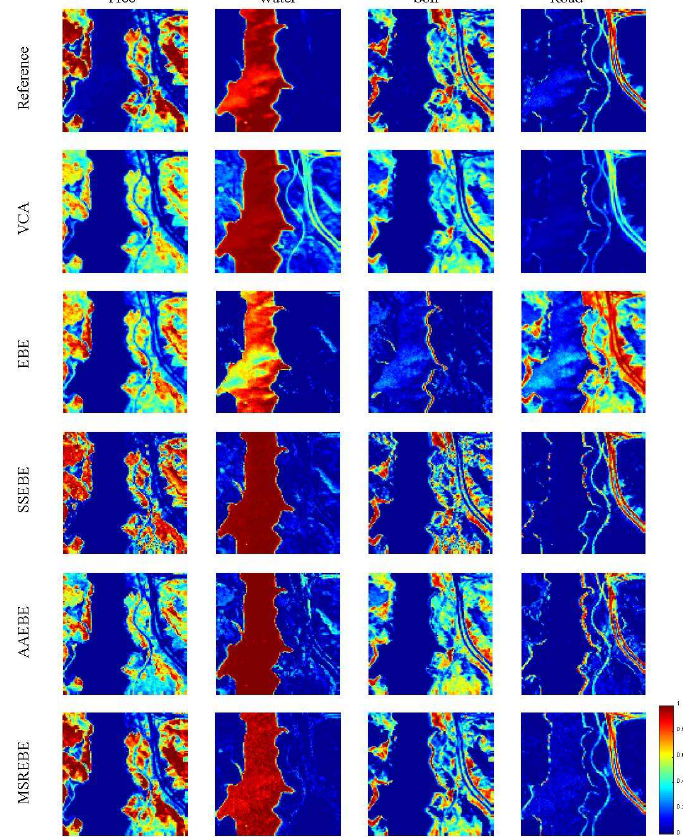
Figure 13. The abundance estimated results of Jasper Ridge dataset.